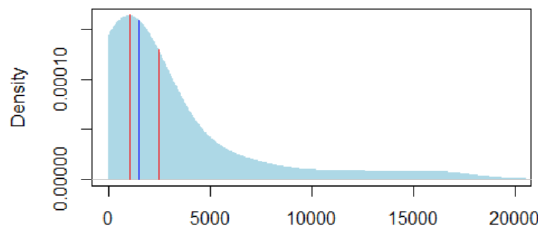
Figure A3. Estimated gain per successful drug development based on Royalty Pharma sales. The x-axis of the two red vertical bars are the mean (2.48 bn$, on the right) and the median ($1.03 bn, on the left) of the sales amounts, in $M. The light blue shade is the density of the sales amount, using a smoothing gaussian kernel whose bandwidth is half of the sales standard deviation. The blue vertical bar, between the two red horizontal bars, is the gain we consider for investors in the megafund, under current longevity trends ($1.5 Bn).